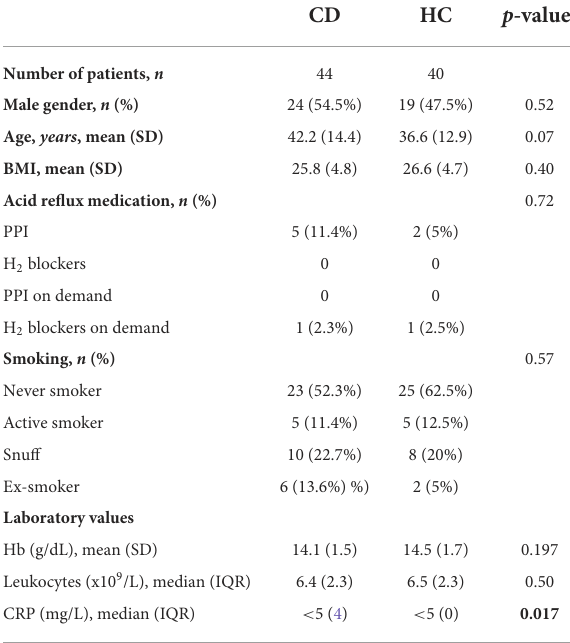
TABLE 1 Demographic and clinical characteristics of Crohn’s disease (CD) patients and healthy controls